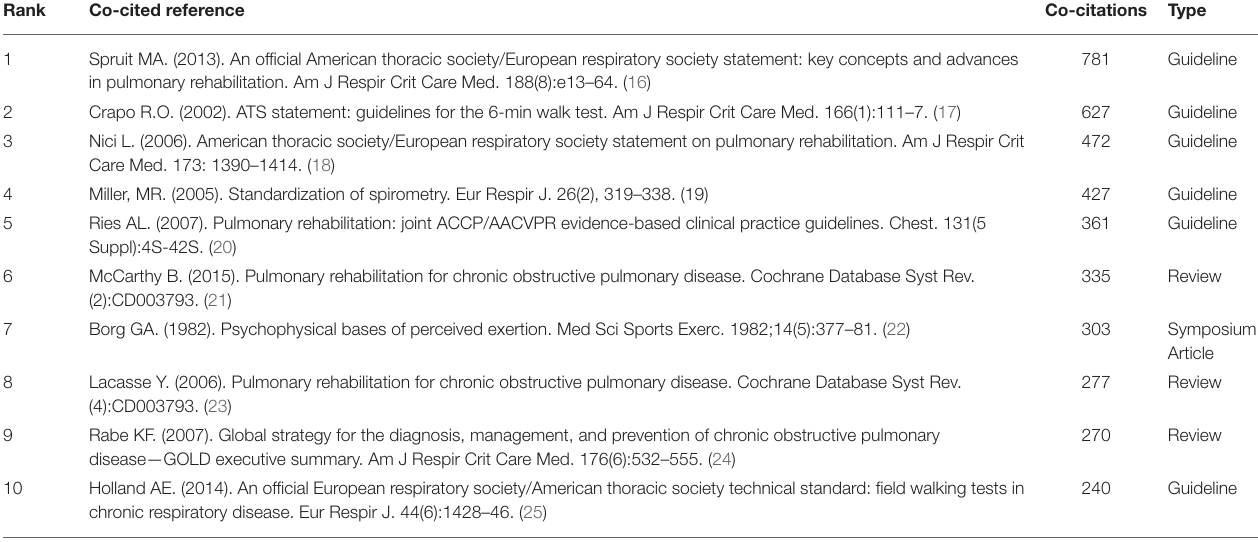
TABLE 5 | Top 10 co-cited reference with high citations related to research on pulmonary rehabilitation.